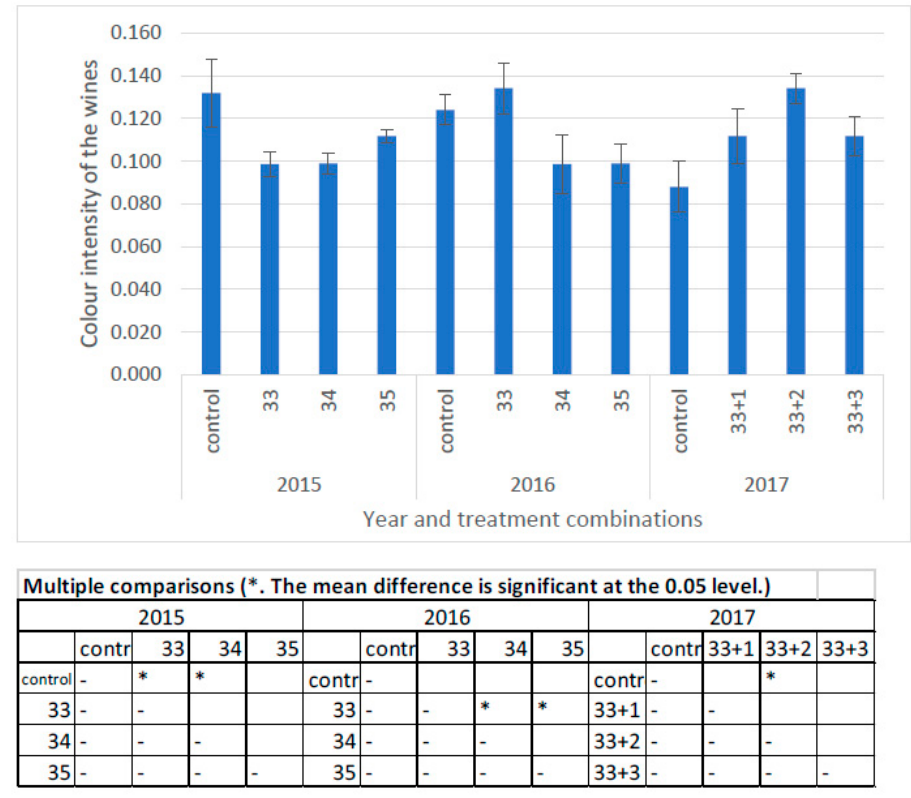
Figure 7. Color intensity of the wines on 420 nm in 2015–2017.